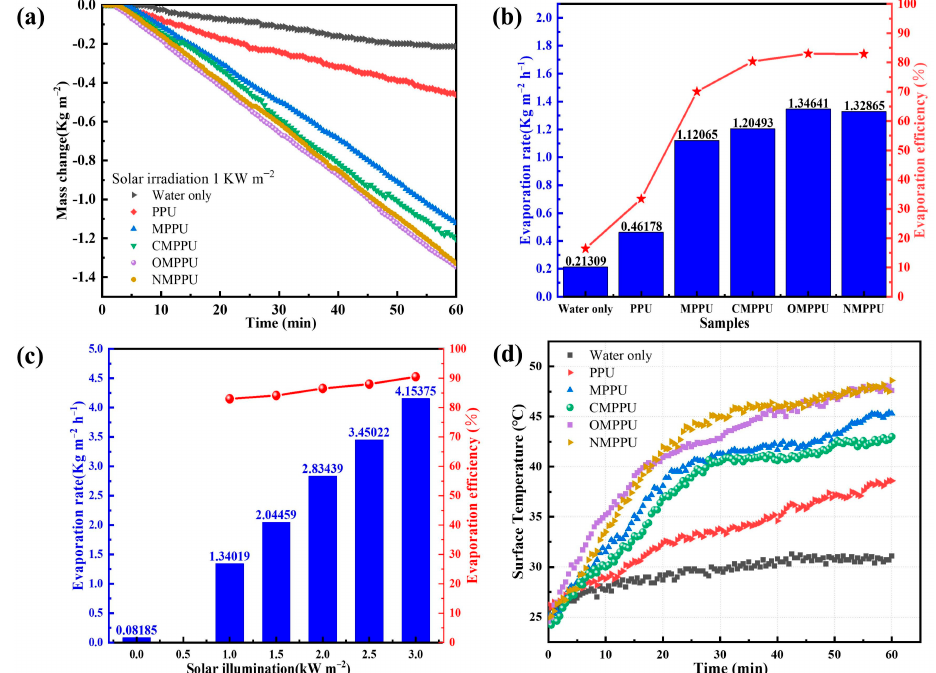
Figure 3. ( a ) Mass change over time of various evaporators under the illumination of 1.0 kW m − 2 . ( b ) Evaporation rates and the corresponding evaporation efficiency of multiple evaporators. ( c ) Evaporation rates and related efficiency under the illumination of 0, 1.0, 1.5, 2.0, 2.5, 3.0 kW m − 2 . ( d ) Temperature variations on the top surfaces of seawater, PPU, MPPU, CMPPU, OMPPU, and NMPPU evaporators as a function of time under the illumination of 1.0 kW m − 2 .